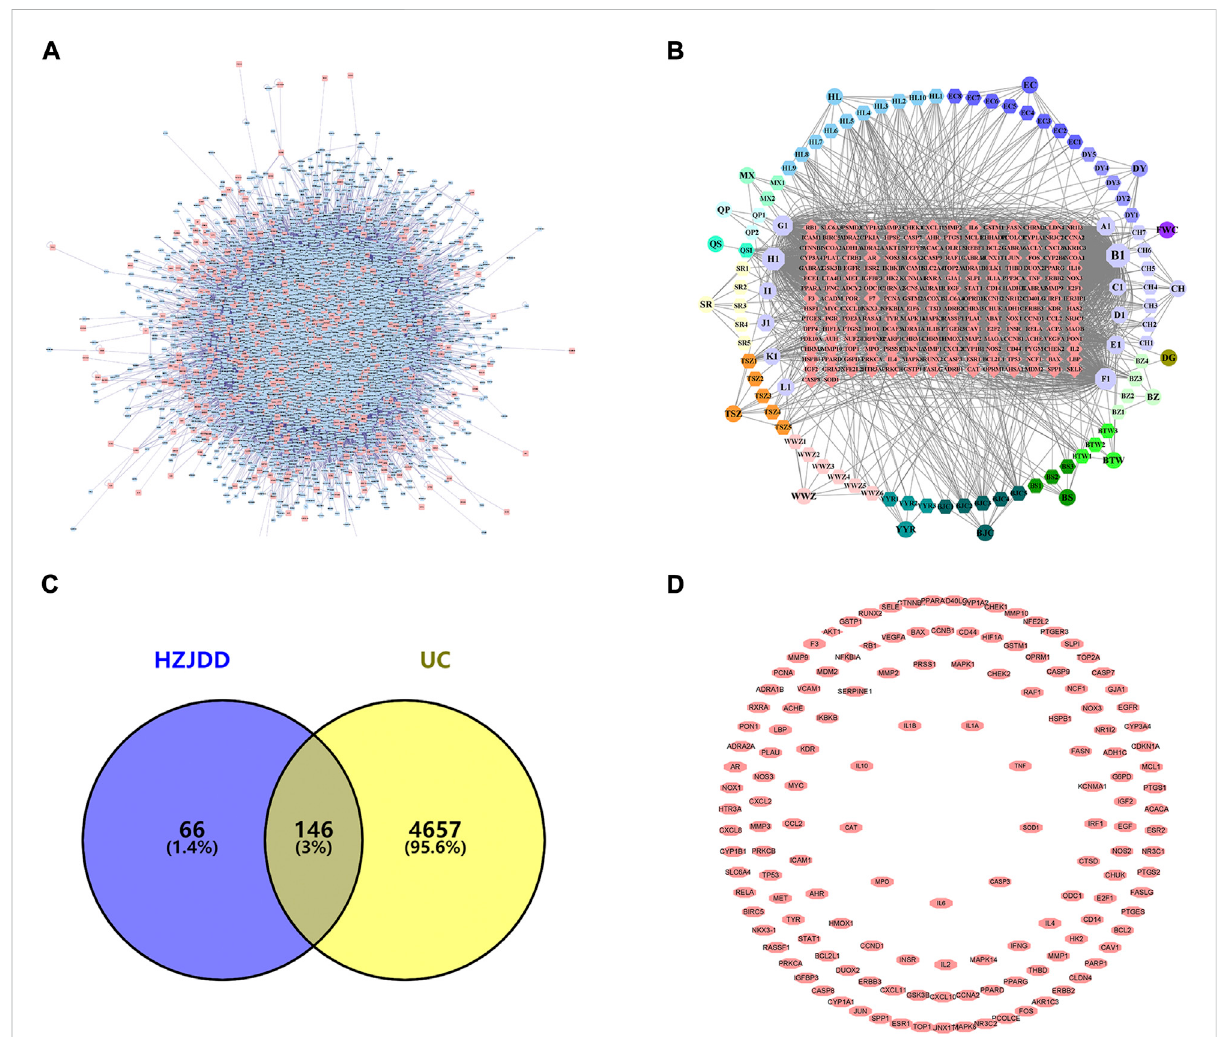
FIGURE 1 PPInetworkofHZJDD-UC. (A) The PPInetworkofUCtargets. (B) The HZJDD-target network. (C) The commontargetsofHZJDD-UC. (D) The PPI network of HZJDD-UC common